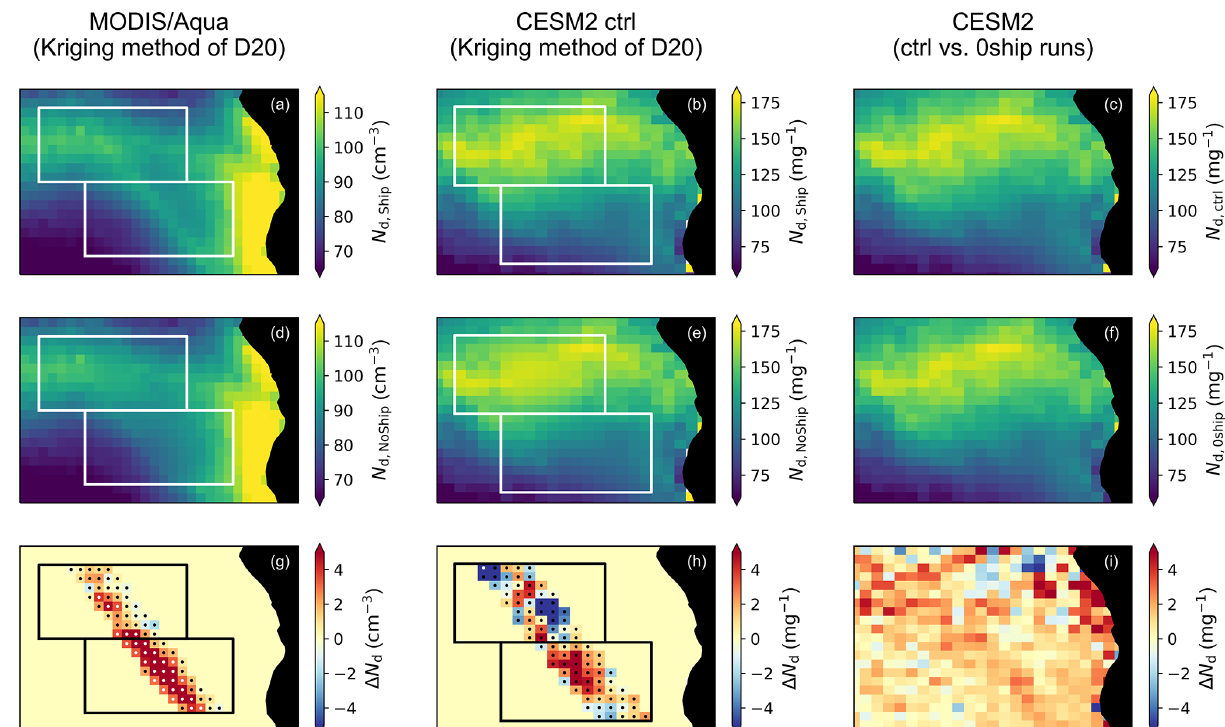
Figure 4. Comparison of Diamond et al. (2020) shipping corridor results for cloud droplet number concentration with CESM2 output. Factual (“Ship”) fields for (a) MODIS/Aqua and (b, c) CESM2 control (“ctrl”), counterfactual (“NoShip”) fields obtained by kriging for (d) MODIS/Aqua and (e) CESM2 ctrl and (f) results from CESM2 with zero shipping emissions (“0ship”), and the (g, h) factual– counterfactual or (i) ctrl–0ship differences. For panels (g, h) , white dots indicate significance at 95% confidence, whereas black dots indicate values that are not statistically